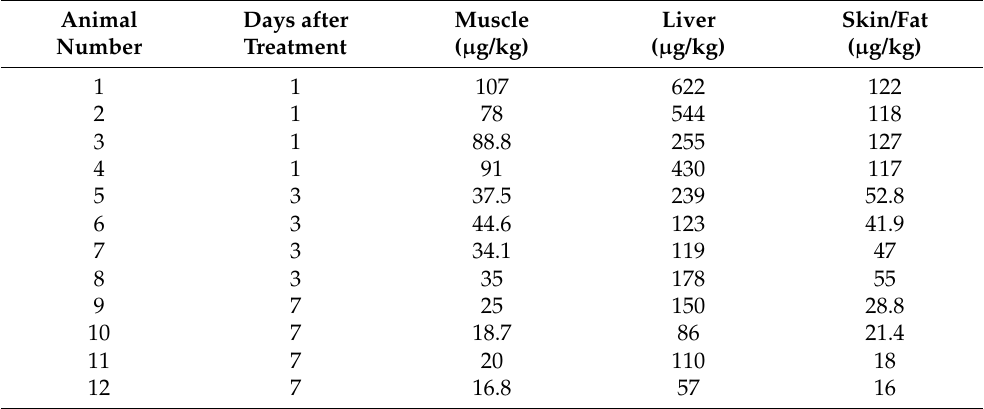
Table 4. Values found in broiler chickens for tiamulin marker residues (dose 20,000 µ g tiamulin/kg body weight/day 7 days).